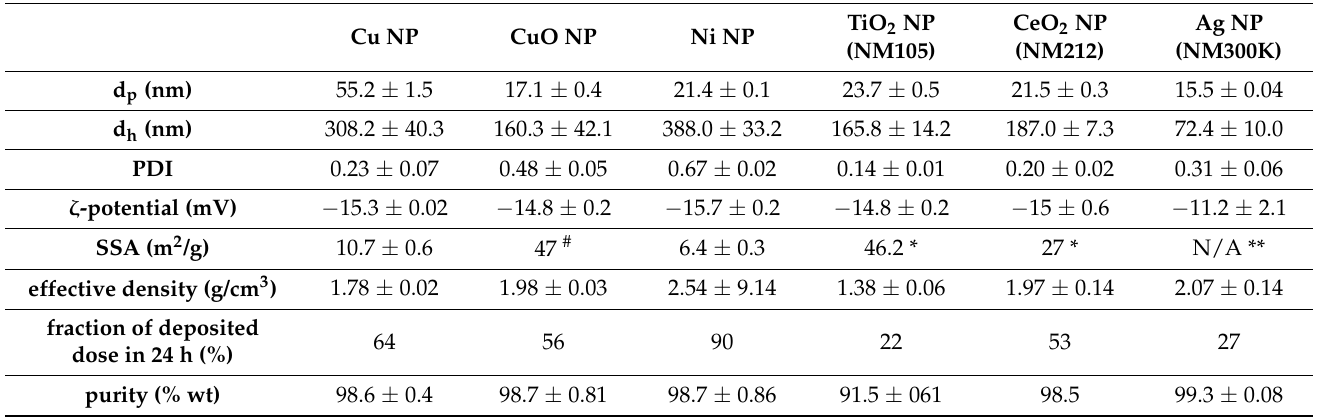
Table 2. Summarized physicochemical properties of the investigated nanoparticles. d p : primary particle diameter determined by transmission electron microscopy, d h : hydrodynamic diameter, PDI: polydispersity index, SSA: specific surface